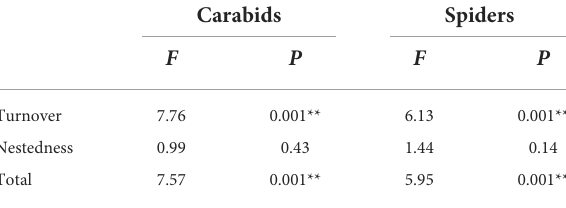
TABLE 1 Results of statistical tests (Anova, P < 0.05) carried out on the constrained analysis of principal coordinates (CAP) which constrained distance matrices of carabids and spiders with system types, i.e., significant P -values indicate a significant differences between system types for each group across both components of beta-diversity (turnover and nestedness) and their total.